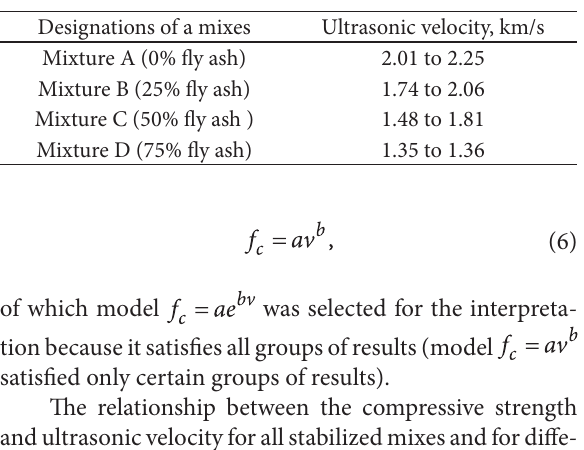
Table 4. Average ultrasonic velocity for specified groups of